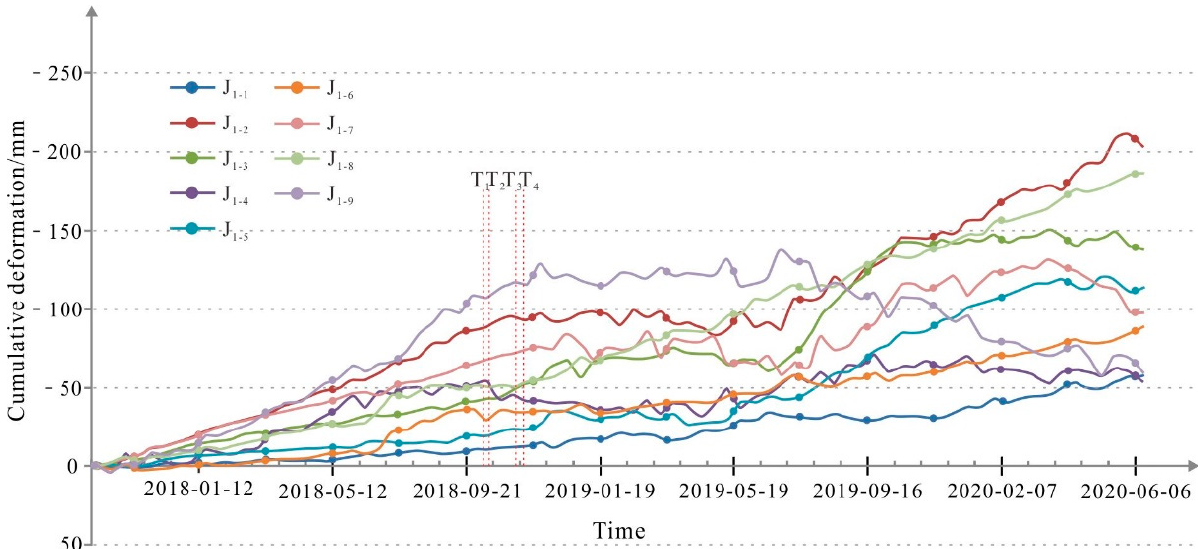
Figure 12. Time series deformation curve of characteristic section A-A’ of the H 1 deformation body from October 2017 to